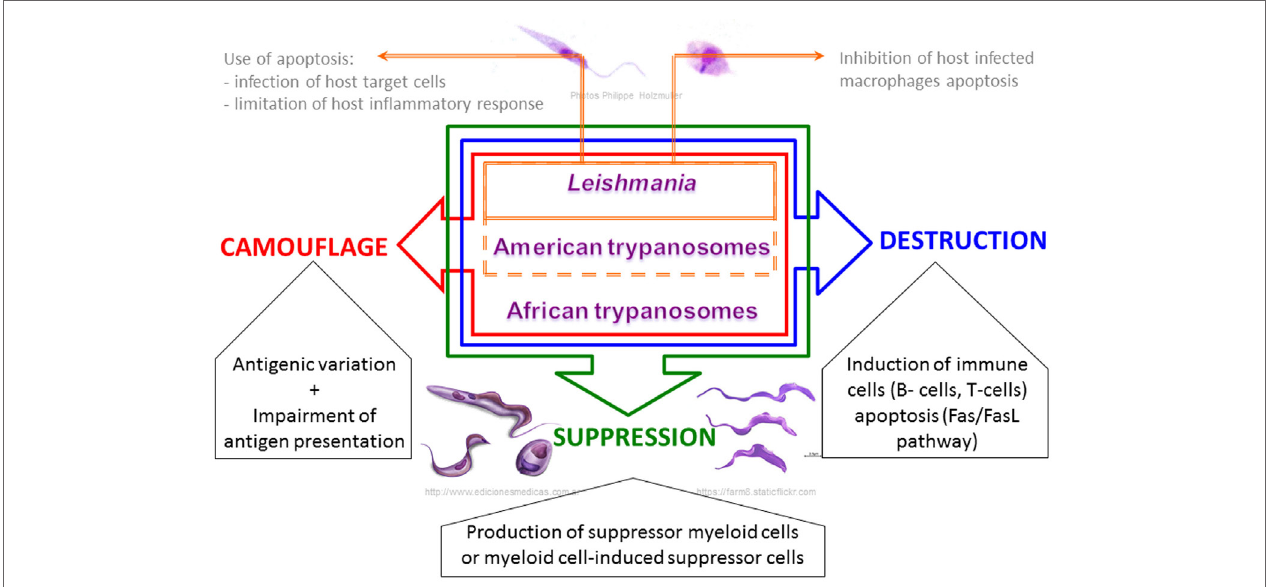
FiGURe 3 | Schematic view of the common strategic arsenal developed by trypanosomatids to interrupt effective host immunity, from immune evasion to immunosuppression